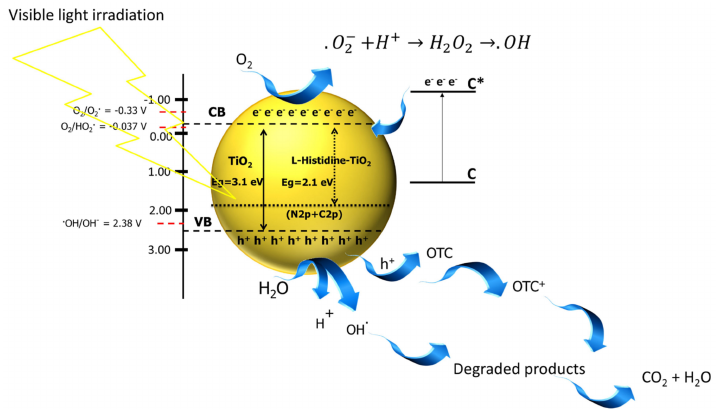
Figure 11. OTC photodegradation mechanism for L-Hisitidine-TiO 2